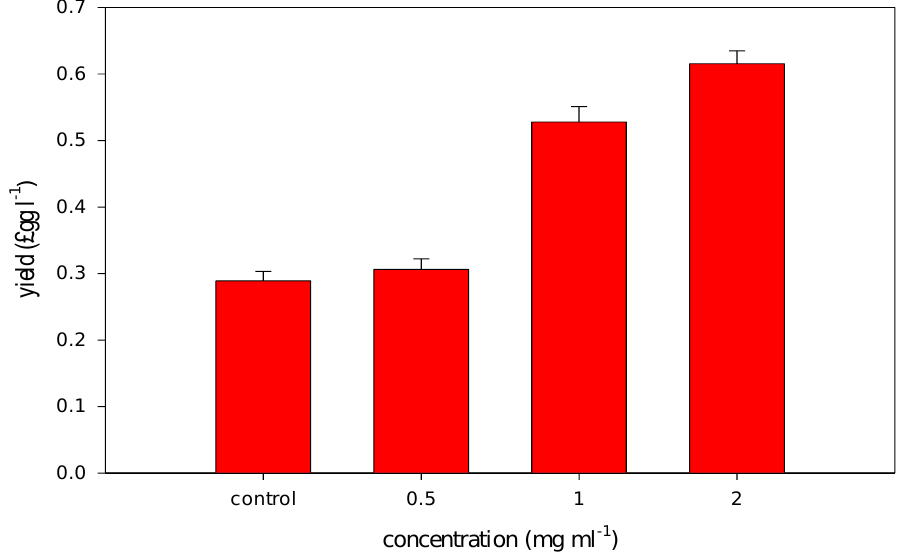
Figure 7. Effect of different concentration Phellinus igniarius polysaccharides on RINm5F cell proliferation.